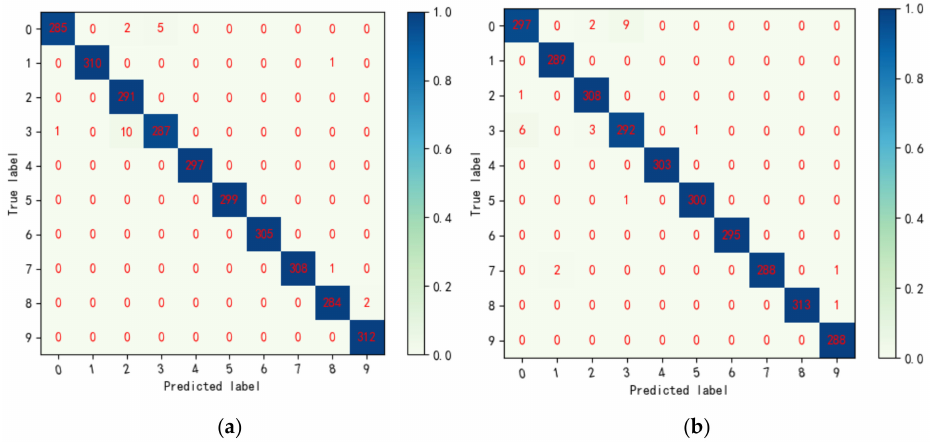
Figure 11. Confusion matrix of the 20th experiment of HSDAE model on data set A. ( a ) The confusion matrix of the HSDAE model in the training set; ( b ) the confusion matrix of the HSDAE model in the testing set.